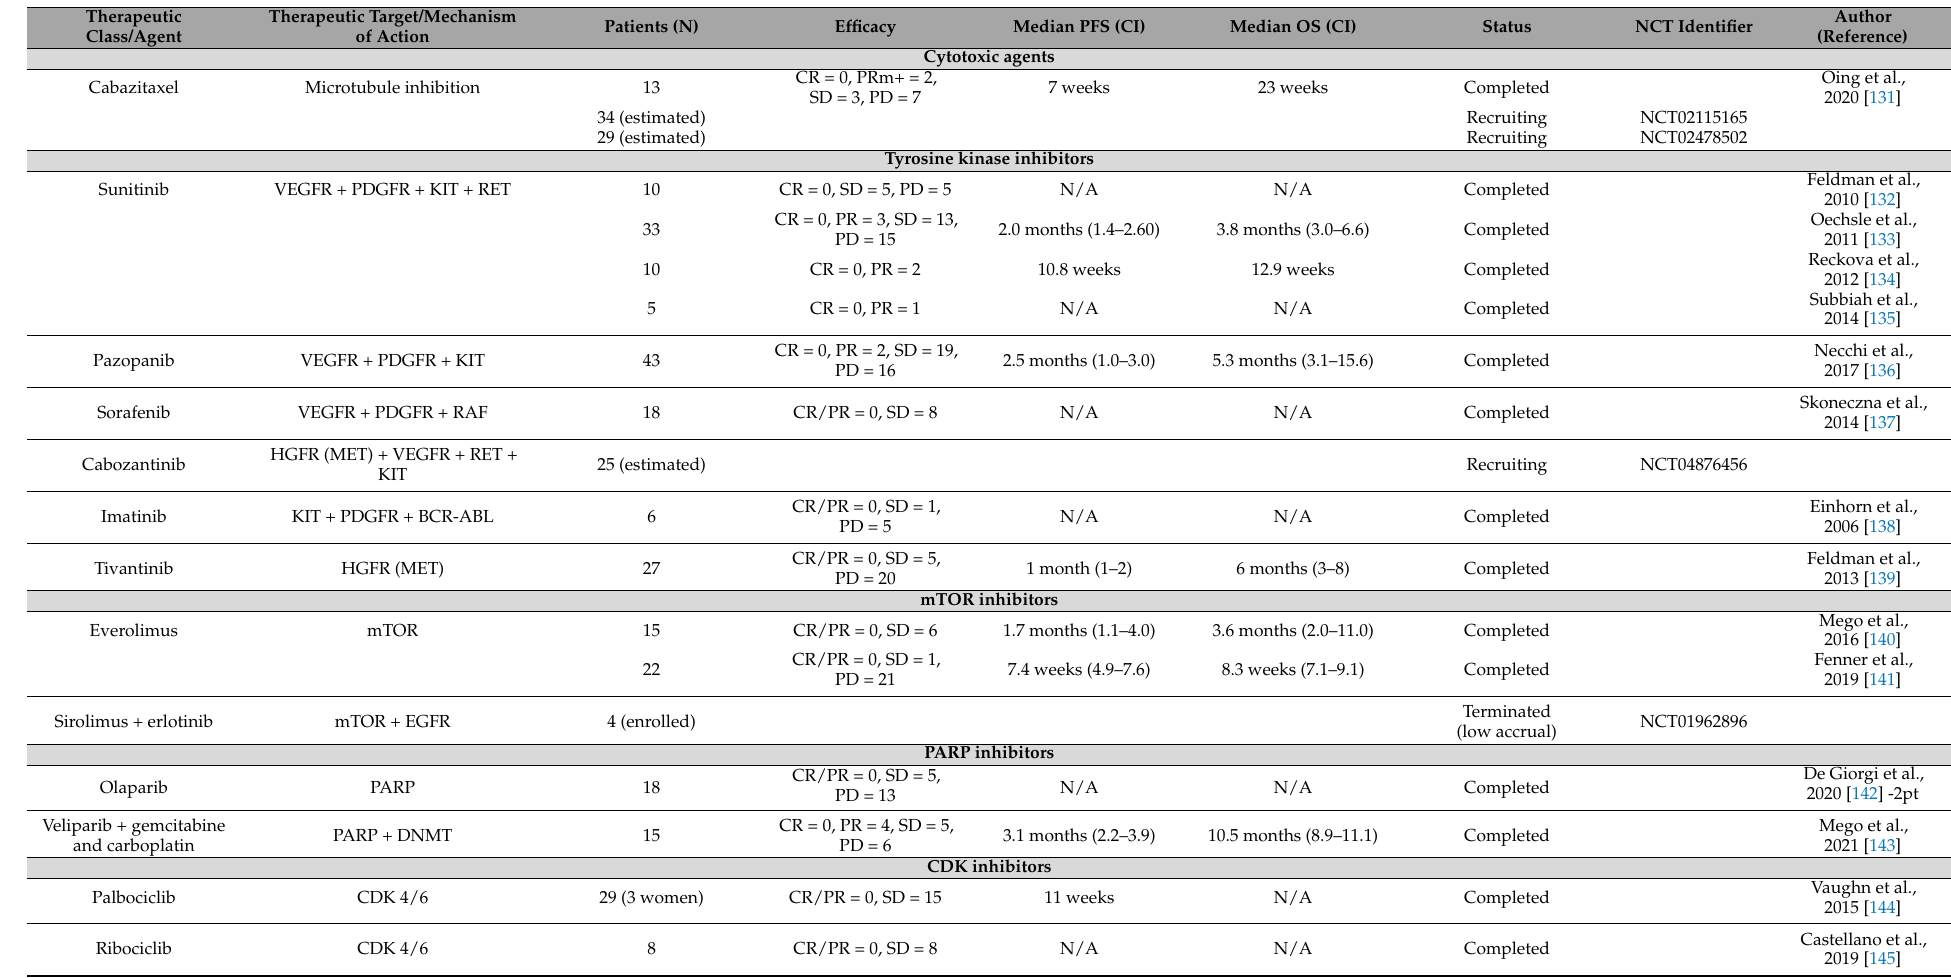
Table 1. Clinical trials of potential therapeutic agents used in refractory germ cell